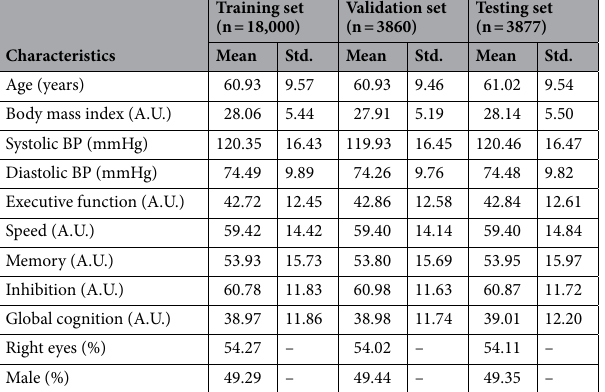
Table 1. Descriptive statistics of predicted variables for each subset of data. Significant values are in bold.